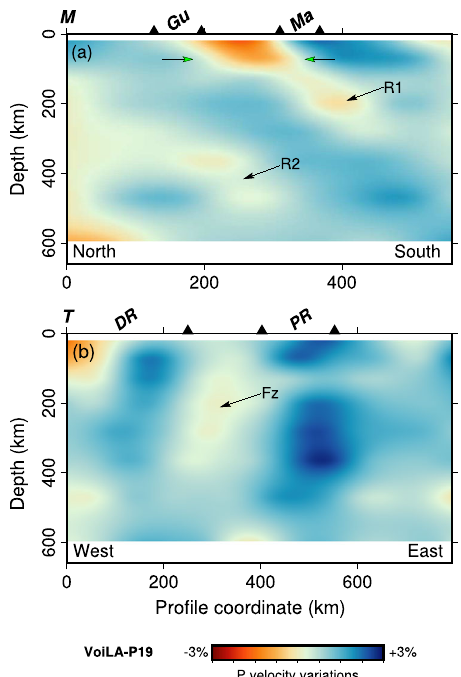
Fig. 6 Two dipping cross-sections along the upper-mantle slab anomalies. Locations of the cross-sections are indicated on Fig. 3a. a Cross section M along the Lesser Antilles Arc. Gu — Guadeloupe, Ma — Martinique. b Cross section T along the slab from Hispaniola to St Kitts. DR — Dominican Republic (Hispaniola), PR — Puerto Rico. Proposed interpretations are marked with arrows: green arrows indicating hydrated mantle wedge, R1, R2 positions of the subducted Proto-Caribbean ridge and Fz — location of a potential tear along a fracture zone.